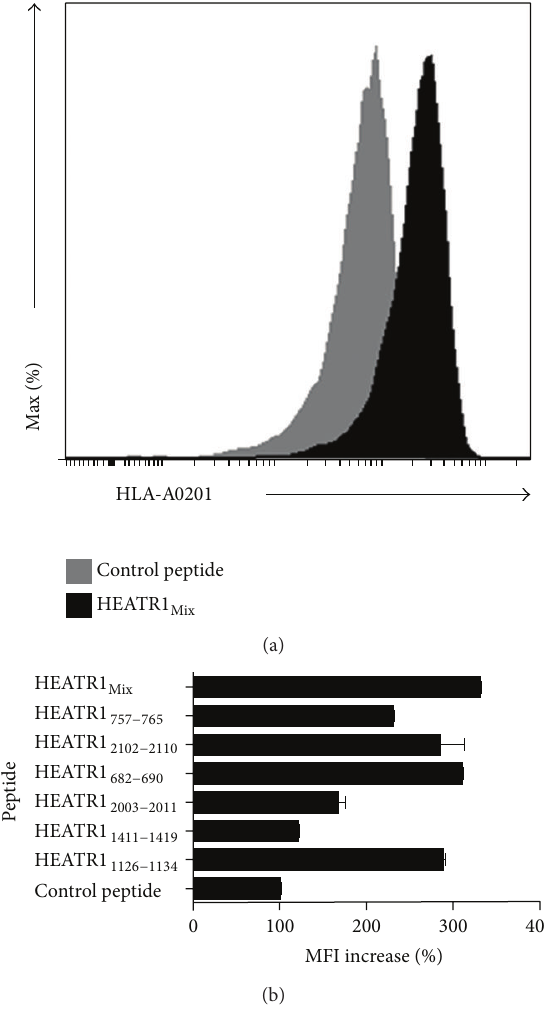
Figure 2: HLA-A02 binding affinity of six candidate peptides. (a) . (b) The binding activity of Flow cytometry results of HEATR 1 mix selected peptides to HLA-A ∗ 02 molecule was determined semi- quantitatively by measuring peptide-induced expression of HLA- A ∗ 02 on T2 cells with flow cytometry. Data from three independent experiments were expressed as the mean ± SE. Unrelated 15-mer peptides were considered as control